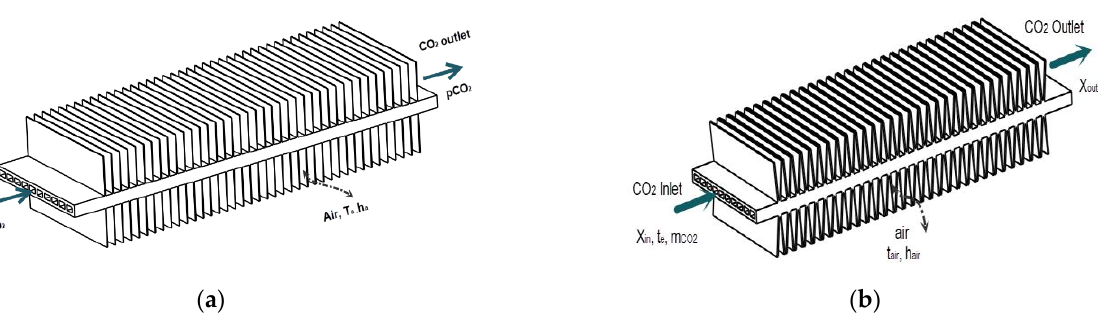
Figure 2. Two flat tube models of the CO 2 microchannel evaporator: ( a ) a model of straight finned flat tube; ( b ) a model of V-finned flat tube. Table 2. Inlet parameters and measured parameters.